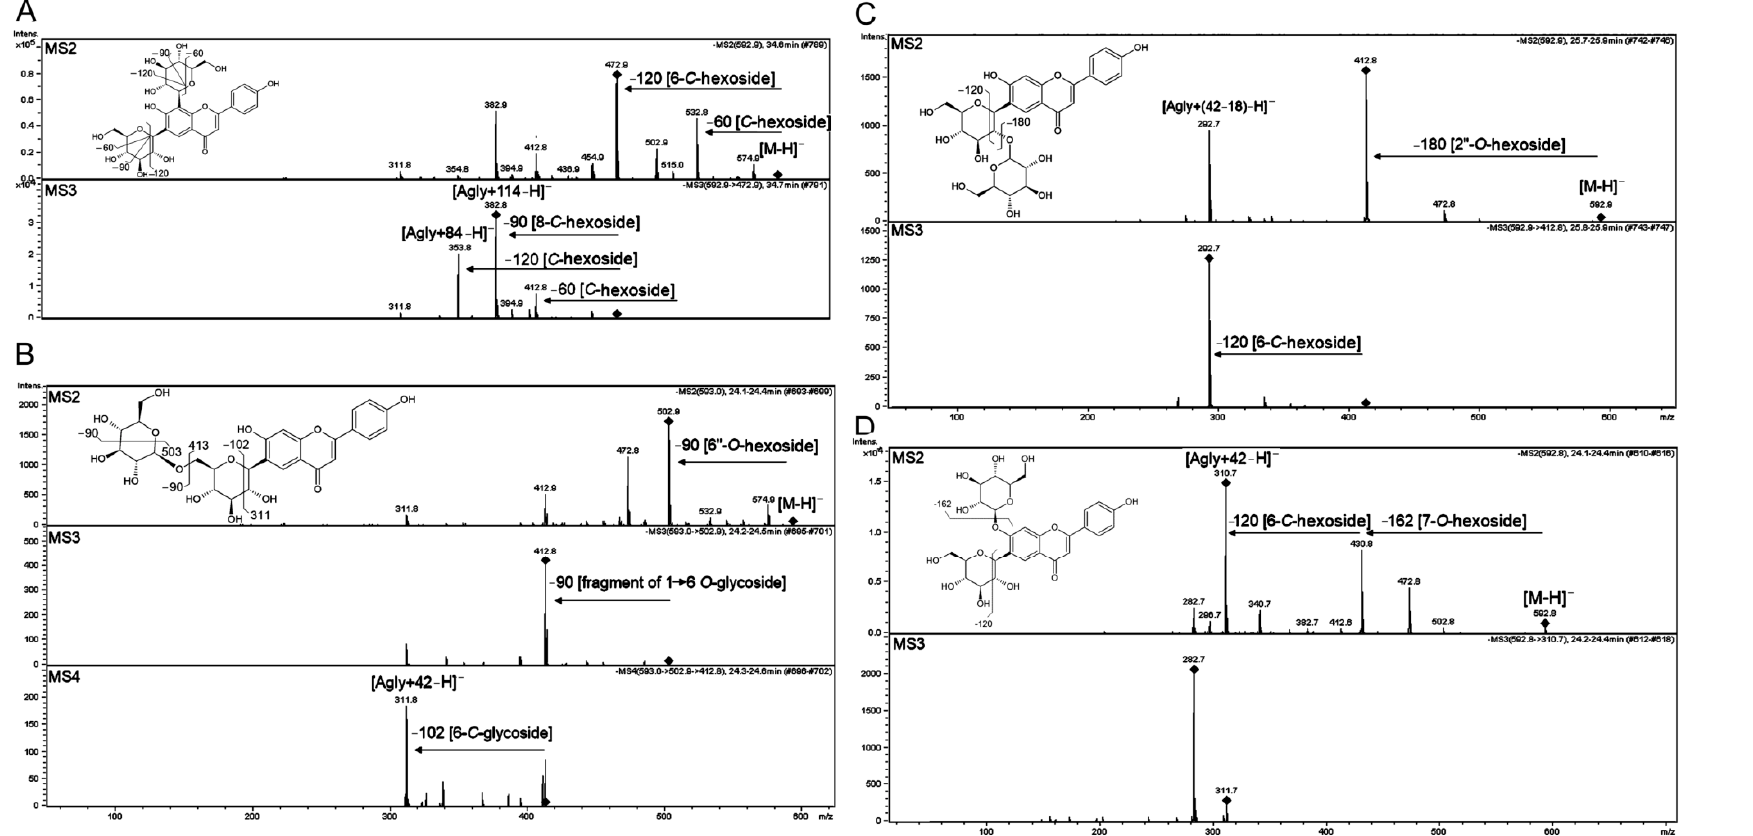
Figure 7. Identification of isomeric structures of apigenin di-glucosides in Brachypodium based on low-resolution MS2, MS3 and MS4 fragmentation spectra obtained in negative ionization. ( A ) Compound 57 , apigenin 6,8-di- C -glucoside, ( B ) compound 68 , apigenin 6- C -[6 ″ - O -glucoside]-glucoside, ( C ) compound 69 ,